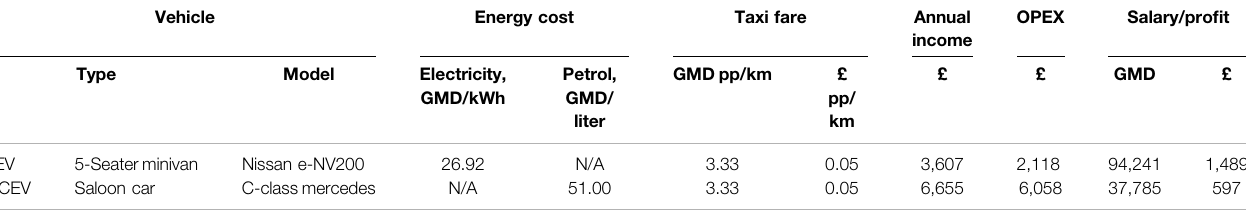
TABLE 1 | Financial summary of current operating conditions for the Solar Taxi and a typical conventional taxi in the Brikama area of The Gambia.